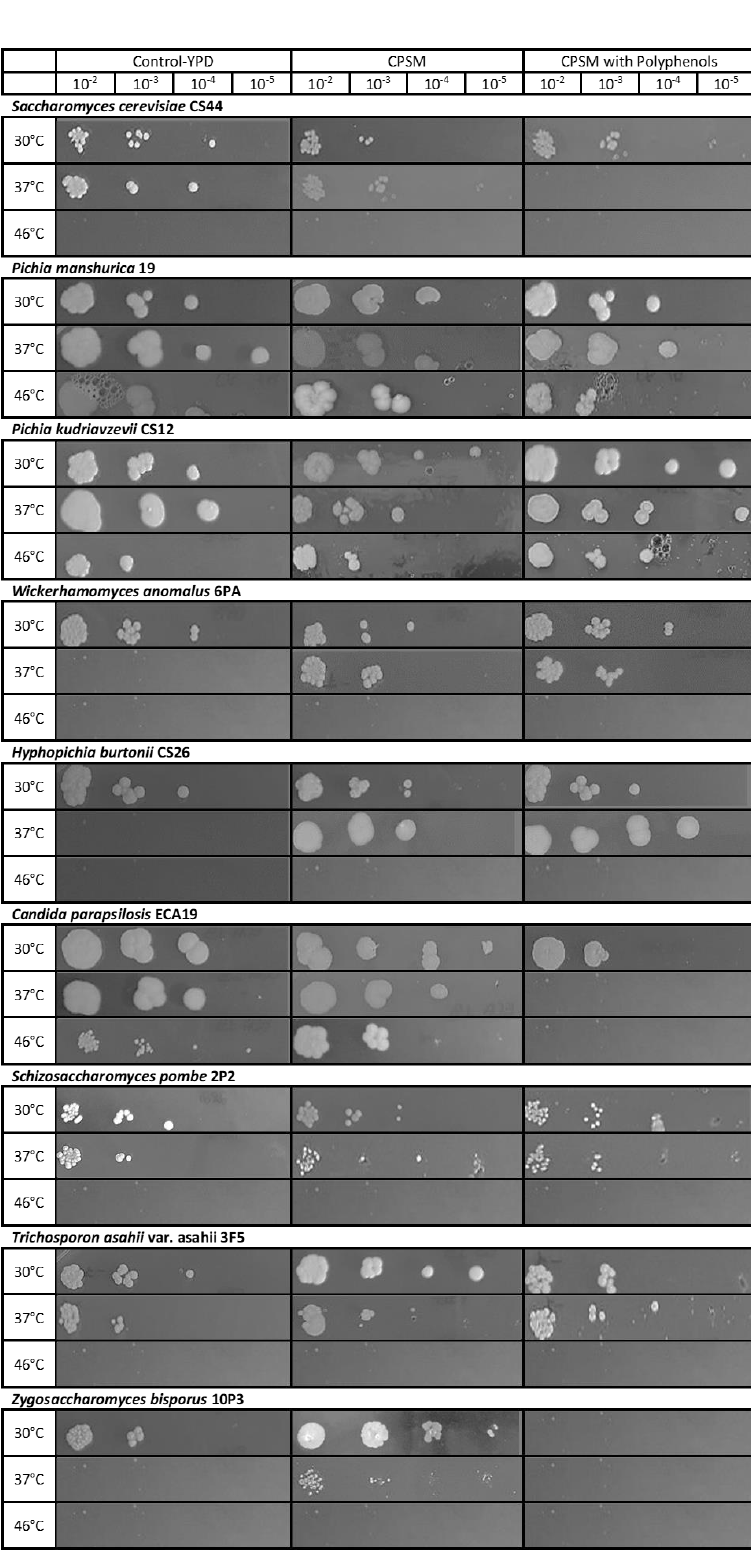
Figure 3. Effects of the medium composition on the thermotolerance of the different yeast species Figure 3. E ff ects of the medium composition on the thermotolerance of the di ff erent yeast species isolated from fermented and dry cocoa beans. CPSM: cocoa pulp simulation medium. isolated from fermented and dry cocoa beans. CPSM: cocoa pulp simulation